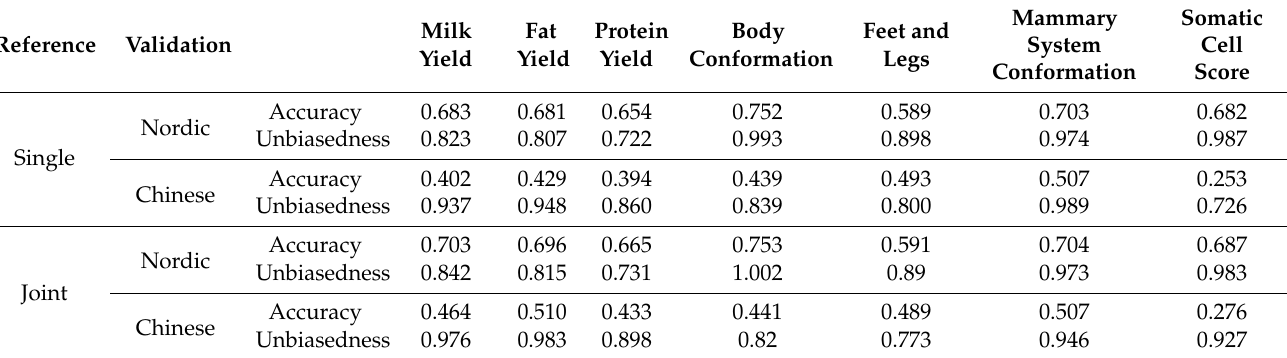
Table 3. Prediction accuracy and unbiasedness regarding the younger individuals with respect to the seven traits in the Chinese and Nordic Holstein populations, as predicted by the single/joint reference